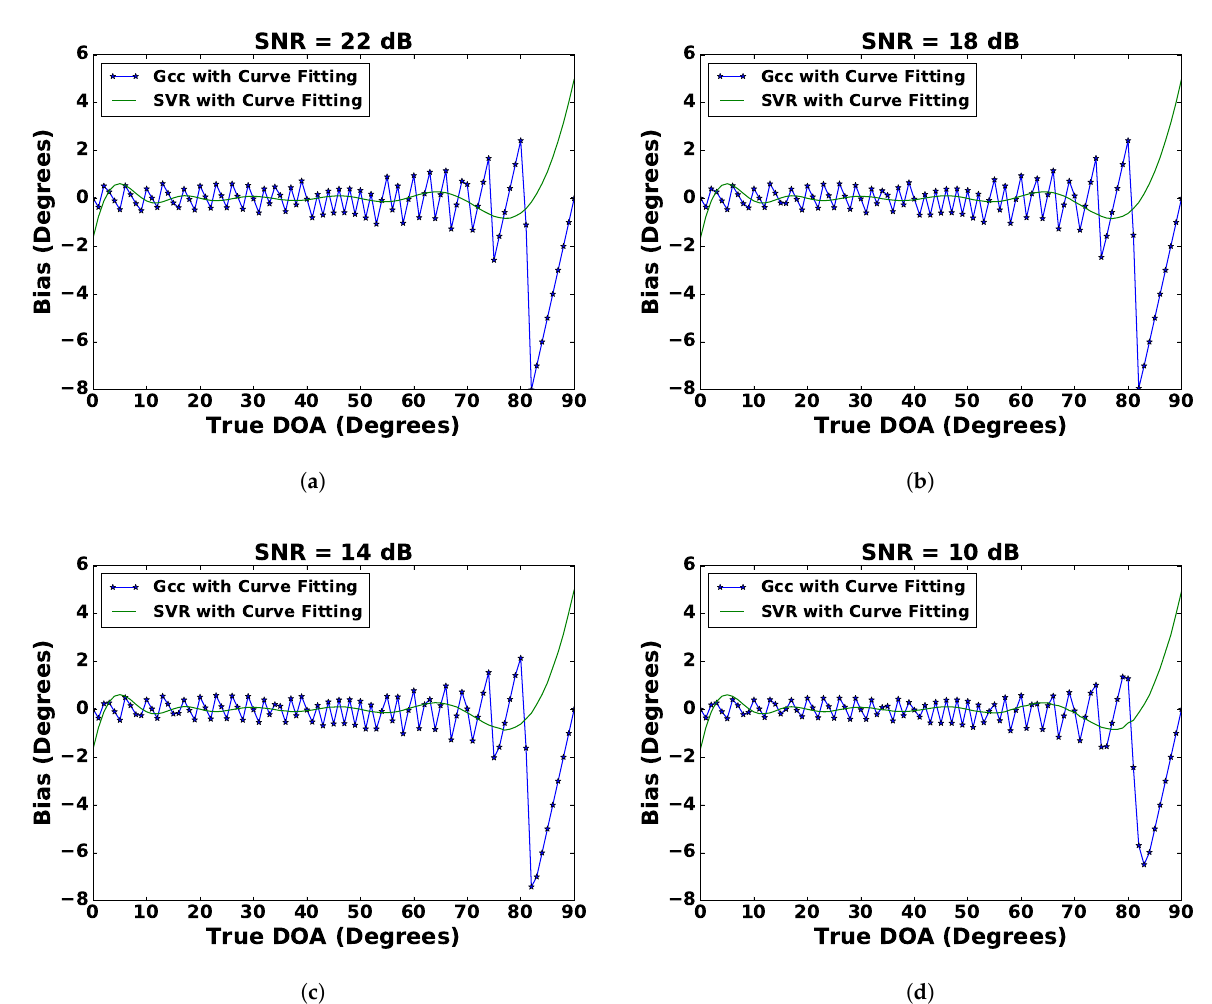
Figure 6. Bias comparison of SVR with curve fitting and the GCC with curve fitting for ( a ) SNR = 22 dB, ( b ) SNR = 18 dB, ( c ) SNR = 14 dB, and ( d ) SNR = 10